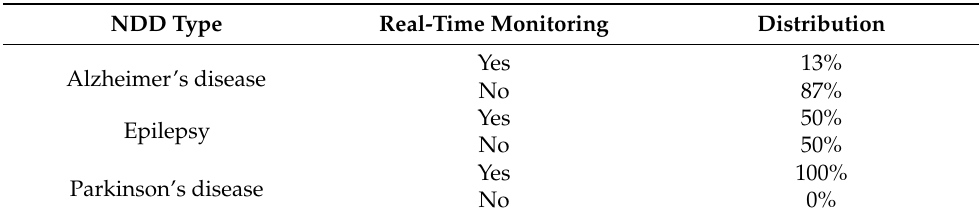
Table 6. Non-Commercial Wearables with Real-Time Monitoring Capabilities.